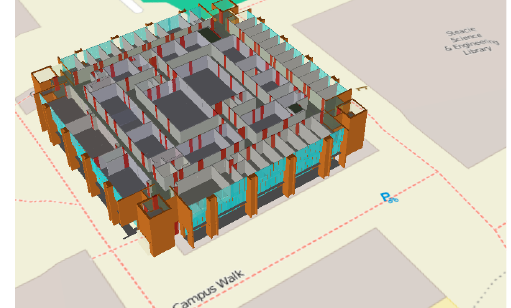
Figure 14. 3D KML model of Petrie Science & Engineering